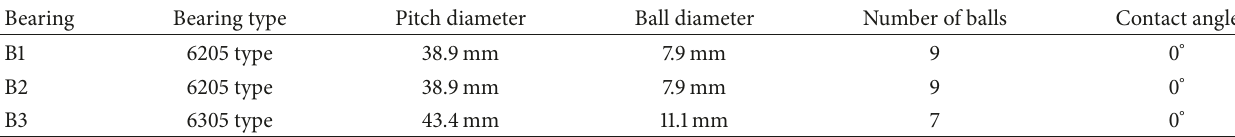
Table 1: The geometry details of test bearings.